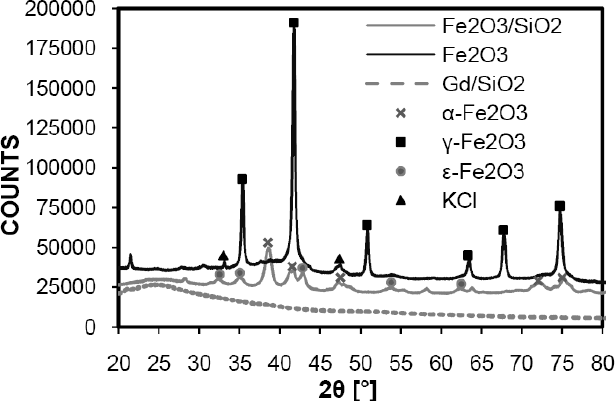
O /SiO , Fe O and Gd III /SiO 2 3 2 2 3